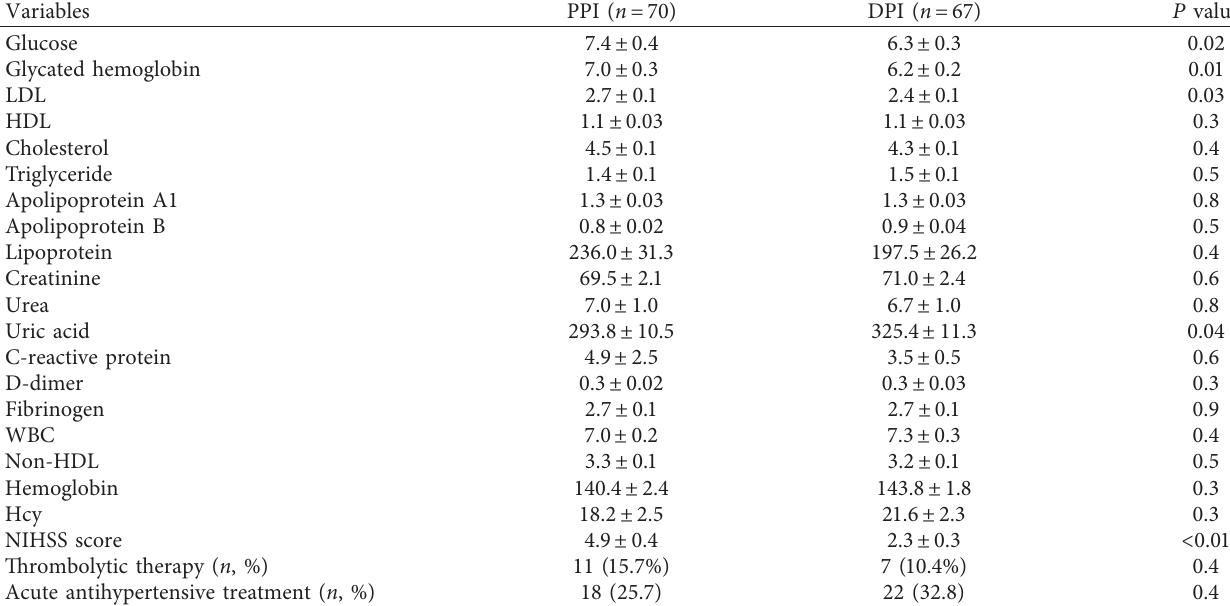
Table 2: The common risk factors and therapies of 136 patients at admission.